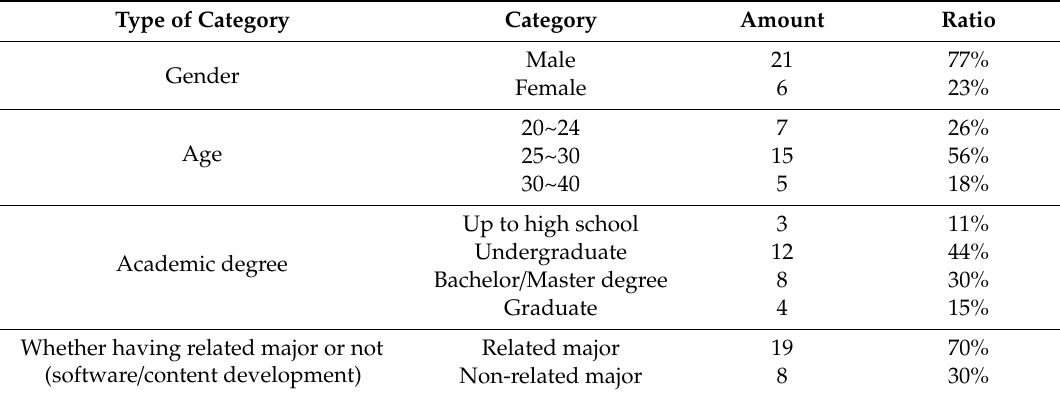
Table 3. Demographic data for the